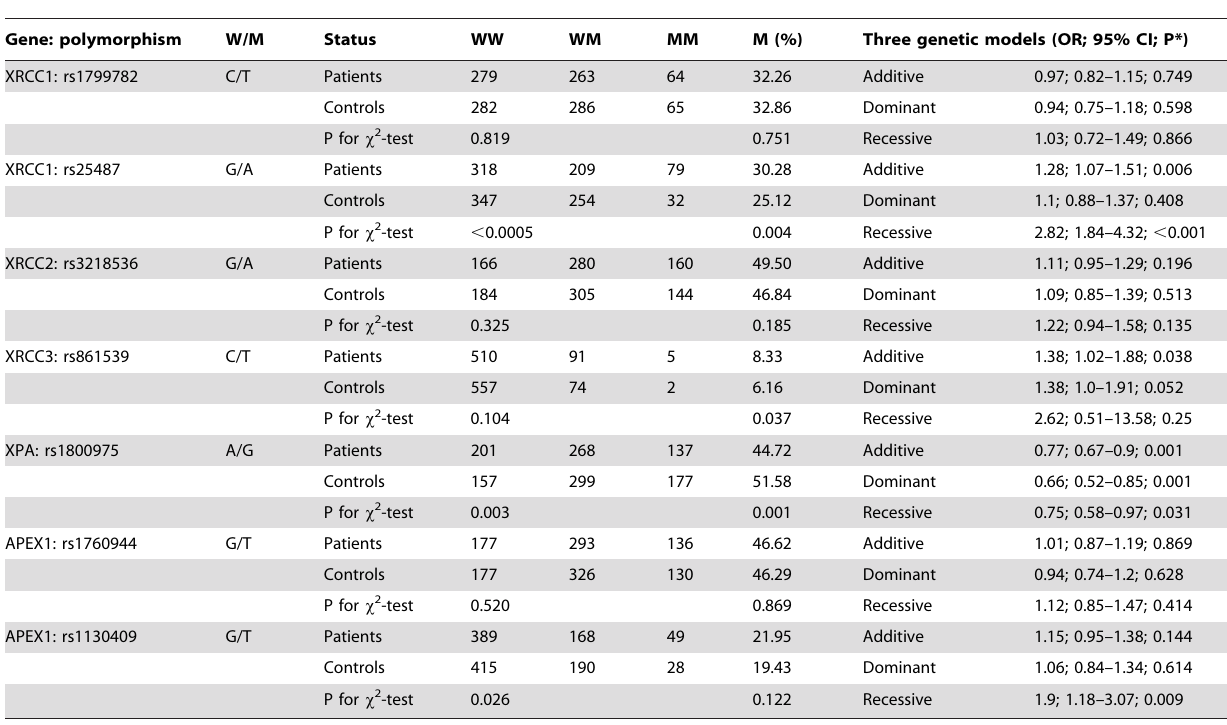
Table 2. Genotype distributions and allele frequencies of seven polymorphisms under study between patients and controls and their risk prediction for breast cancer under three genetic models of